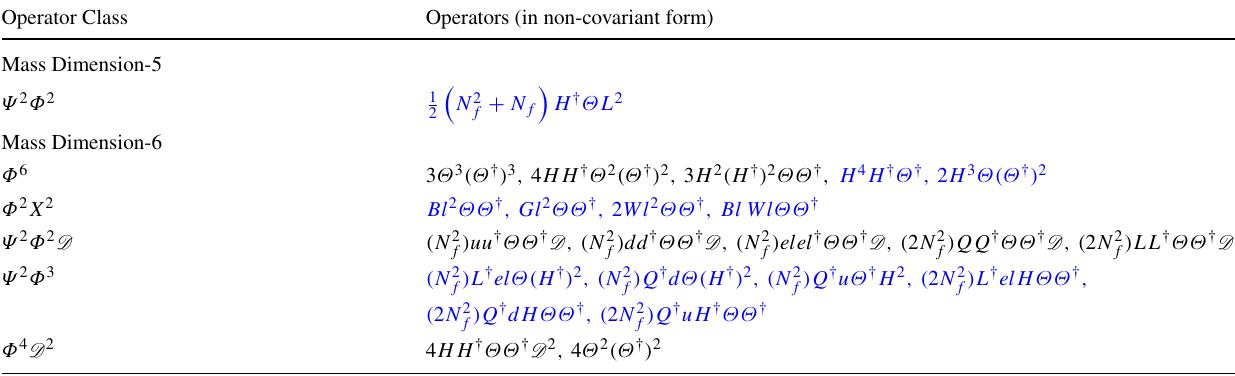
Table 34 SM + SU ( 2 ) quadruplet scalar( Θ ): operators of mass dimensions-5 and -6 excluding pure SM operators